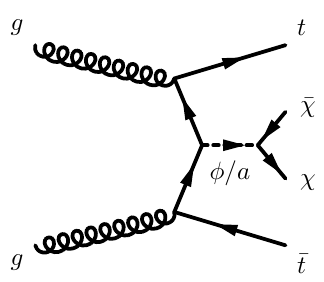
Figure 2. A representative Feynman diagram for spin-0 mediator production. The φ / a is the scalar/pseudoscalar mediator, which decays into a pair of dark matter ( χ )